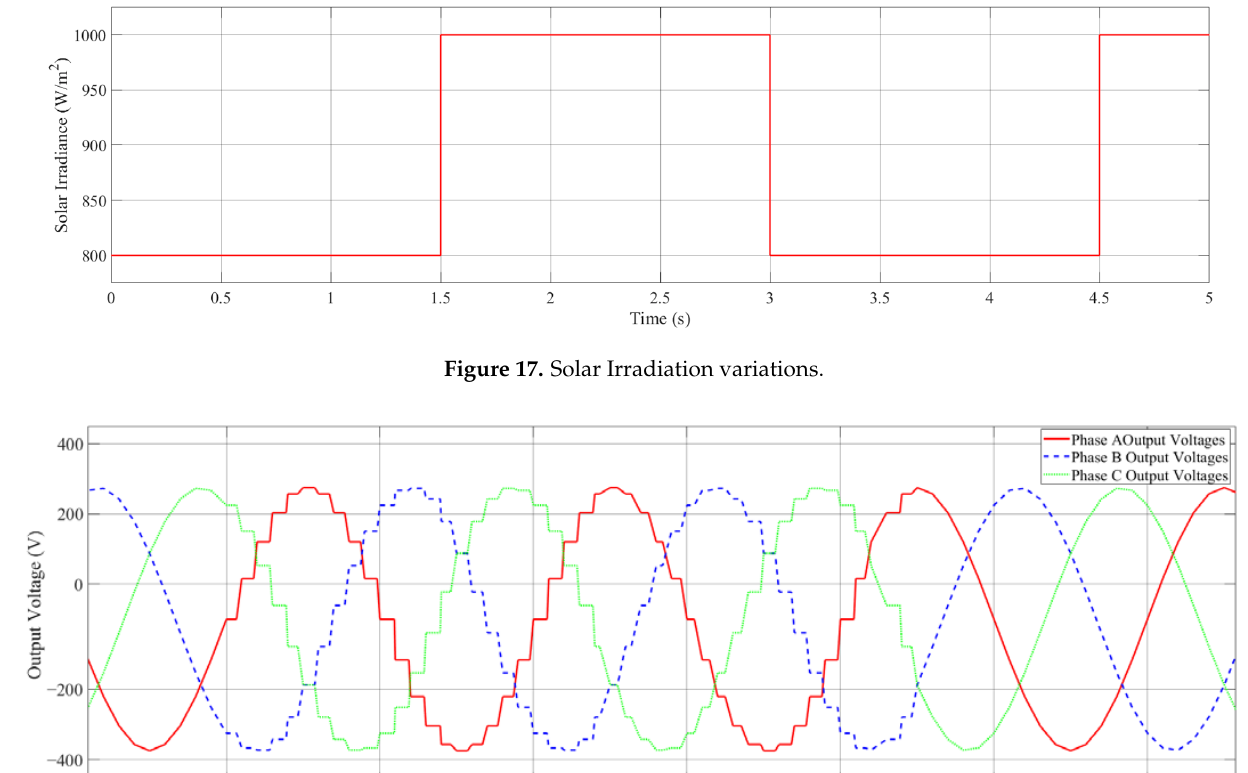
Figure 18. Output voltage zoomed view in ABC frame during solar radiations variations.